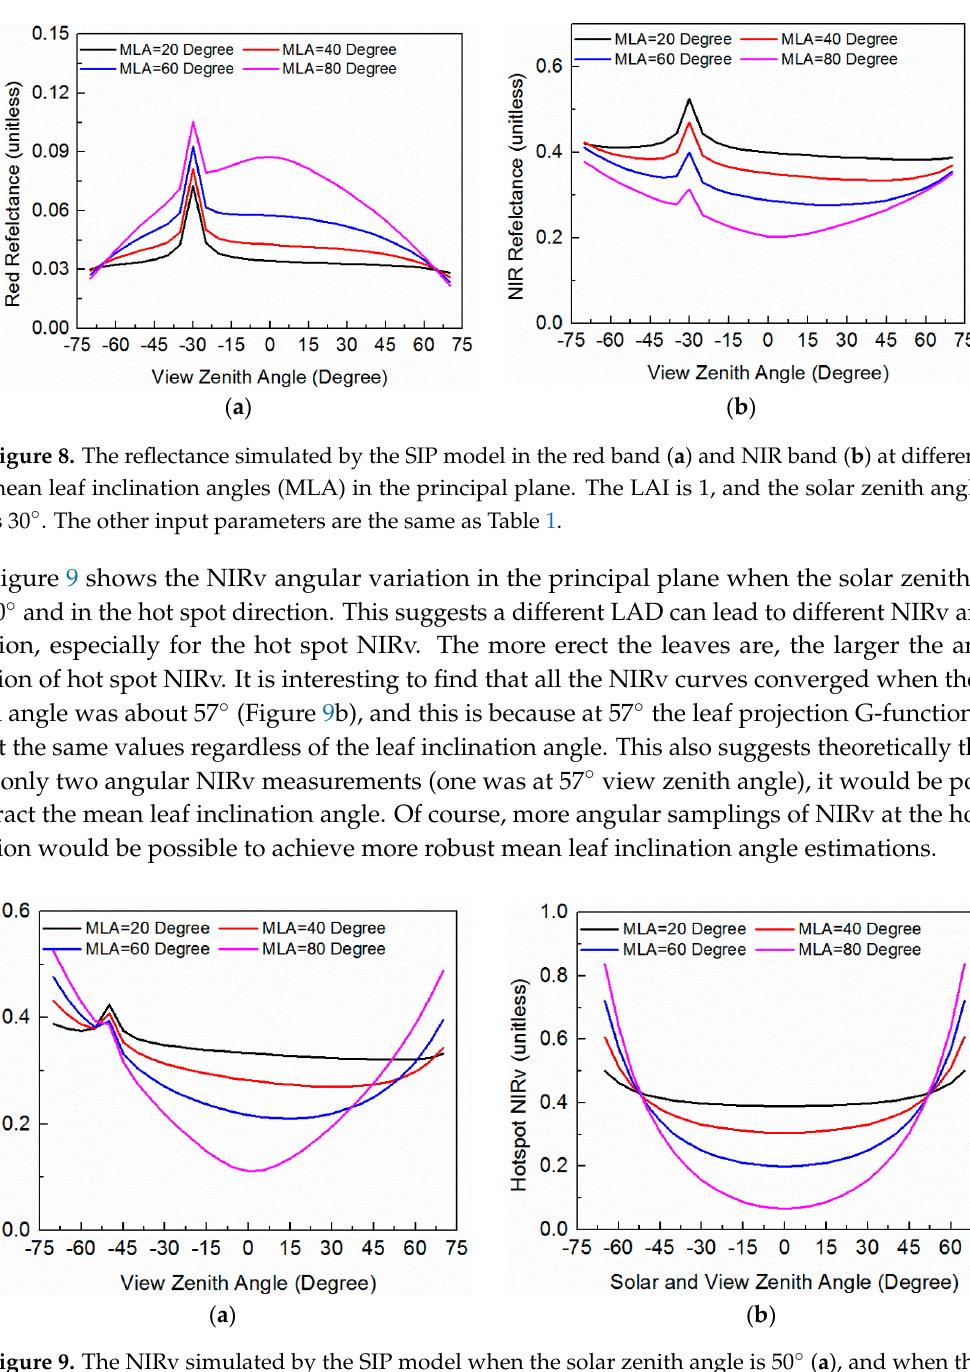
Figure 9. The NIRv simulated by the SIP model when the solar zenith angle is 50° ( a ), and when the solar direction coincides with the view direction for hot spot observation ( b ). MLA represents the mean leaf inclination angle. The LAI is 1, and other input parameters are the same as Table 1.